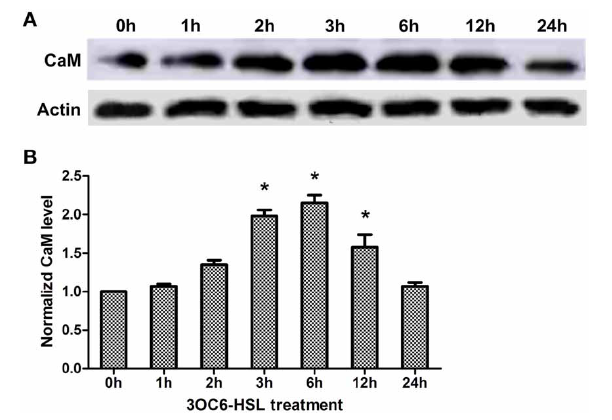
FIGURE 4 | Effects of 3OC6-HSL on the accumulation of CaM protein in Arabidopsis roots. The plants were grown in hydroponic Hoagland medium with or without 1 μ M 3OC6-HSL. Total protein was extracted from roots at different time interval after 3OC6-HSL treatment. (A) The change of CaM protein level detected by western blot. Actin was used as an internal quantification control. (B) The change of CaM protein level detected by ELISA using polyclonal antibody against wheat CaM. The results were normalized to the CaM protein level of untreated samples. Each value was the average of three independent experiments. Entries with p -values < 0.05 shown with asterisk.